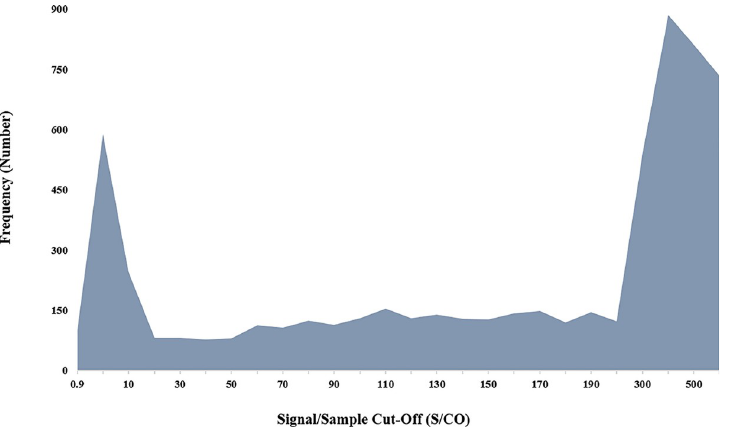
Fig 3. The frequency of HIV-S results’ signal distribution over the positive range. The chart depicts the bimodal distribution of sample signals peaking in the low positive and equivocal as well as the high positive range.